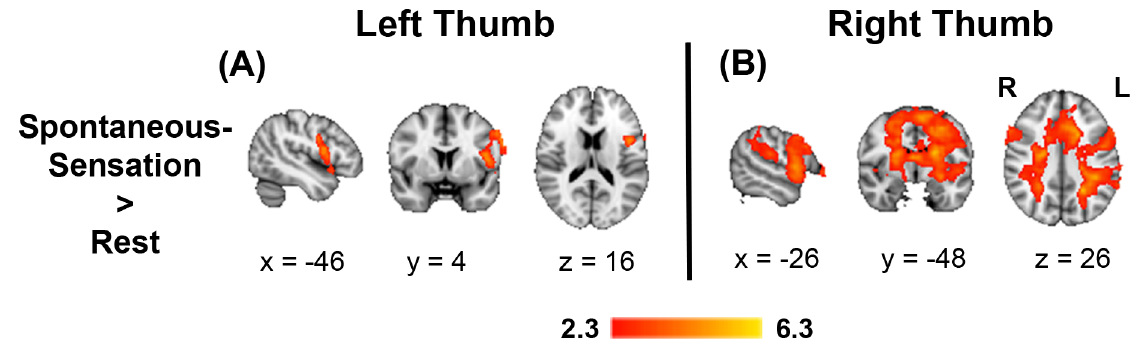
Figure 2. Spontaneous-Sensation analysis: Overall activations associated with focusing of attention during the different phases of the experimental paradigm. A) Focusing attention on Spontaneous-Sensation of the left thumb. B) Focusing of attention on Spontaneous- Sensation of the right thumb. All statistical maps had a significance threshold of Z . 2.3, with a cluster significance threshold of p , 0.05 (corrected for multiple comparisons). Images are presented in radiological convention and mapped to the MNI-152 template.